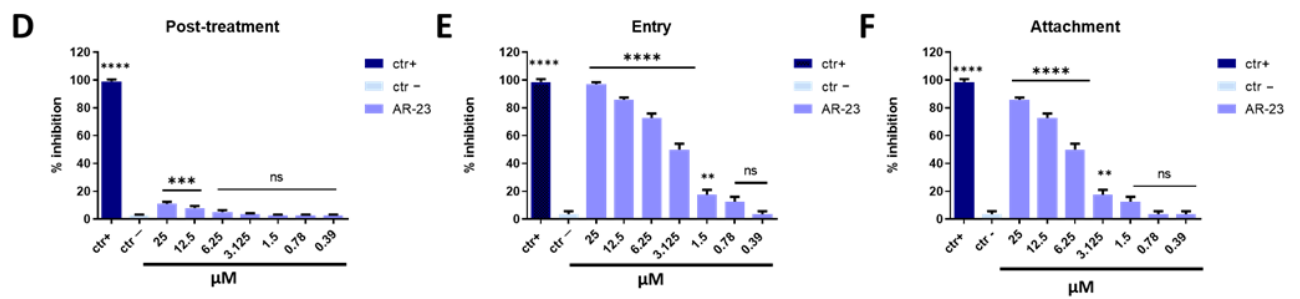
Figure 2. Antiviral activity against HSV-1. Different assays were performed in order to evaluate anti-HSV-1 activity. ( A ) Co-treatment: simultaneous addition of AR-23 and virus to the cells; ( B ) Virus pre-treatment: virus incubated with the peptide, and then used to infect cells; ( C ) Cell pre-treatment: AR-23 incubated with the cells before the viral infection; ( D ) Post-treatment: AR-23 added to the infected cells; ( E ) Entry: cells infected with the virus at 4 °C and then treated with AR-23 at 37°C; ( F ) Attachment: AR-23 and virus incubated together with cells at 4 °C. The peptide inhibited the early stages of infection, acting in co-treatment ( A ) and virus pre-treatment ( B ) assays, while it was not able to interact with the cellular surface ( C ) or block the viral replication ( D ). AR-23 blocked the entry ( E ) and attachment ( F ) of HSV-1 on the host cell. Different compounds were used as positive control (ctr+) for each treatment: melittin ( A , B , 5 μ M for both the assays), dextran sulfate ( C , 1 μ M), aciclovir ( D , 5 μ M) [35] , and heparin ( E , F , 1 mg/mL for both the assays) [36] , while infected cells were used as negative control (ctr-). **** p < 0.0001; *** p < 0.0002; ** p < 0.0021; * p < 0.021; ns: non-significant.